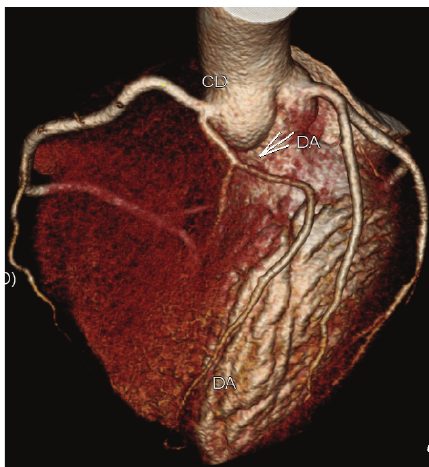
Figure 4: CT angiography confirming the anomalous (interarterial) course of the long LAD artery (white arrow) from the right sinus of Valsalva (close to the RCA ostium), coursing along the distal part of the AIVS (the pulmonary trunk was removed). CT, computed tomography; LAD, left anterior descending artery; RCA, right coronary artery; AIVS, anterior interventricular